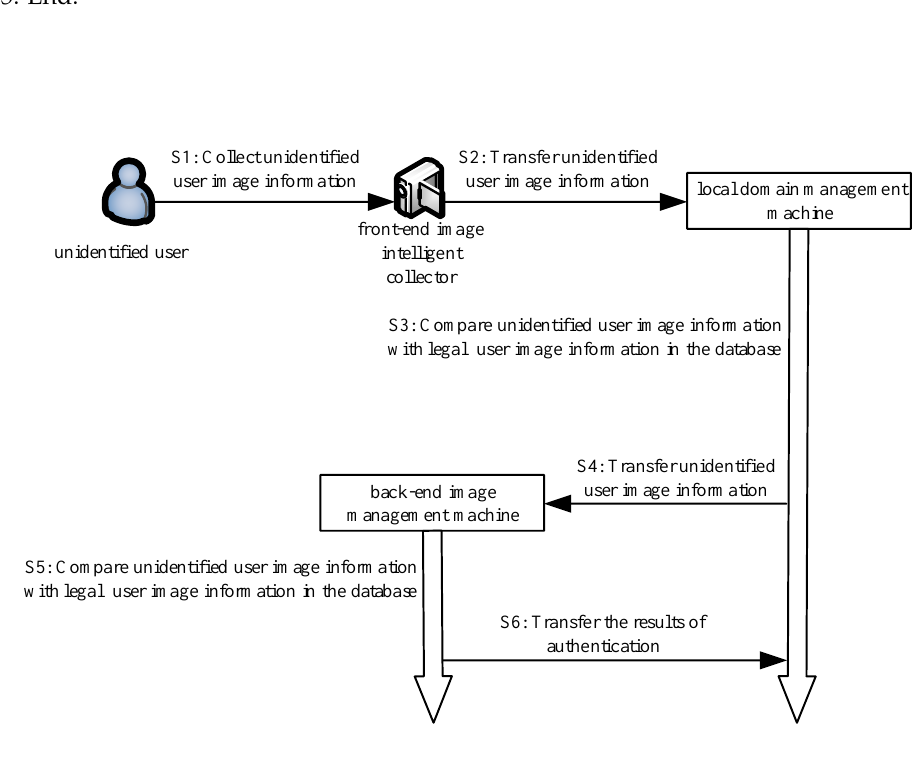
Figure 3. The authentication phase of the local domain management machine and the back-end image management machine brief process